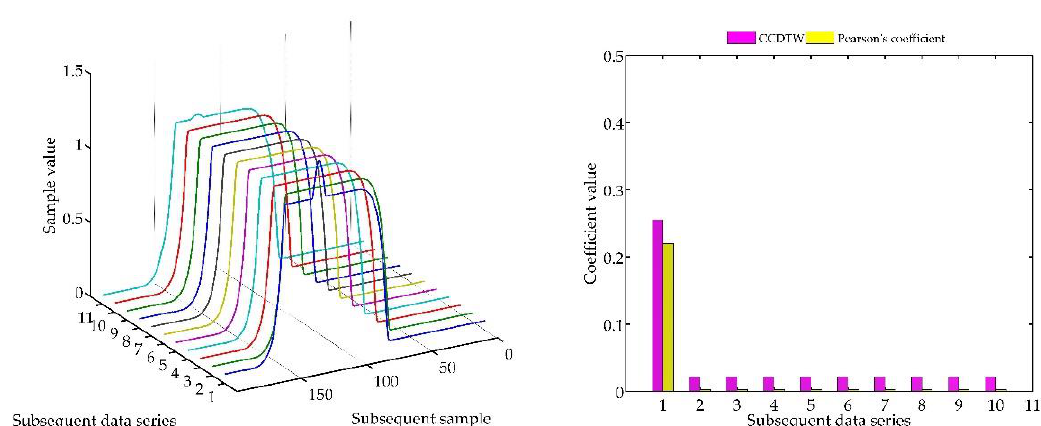
Figure 20. Simulation results achieved for data shifted by +10 samples for the first series (blue line) for r ampl = 2.